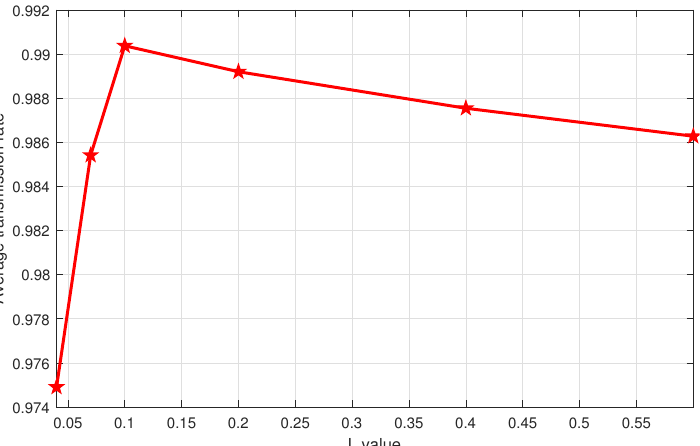
Figure 3. Performance comparison of (cid:101) -decreasing greedy for different L values after T = 1000 iterations in Scenario